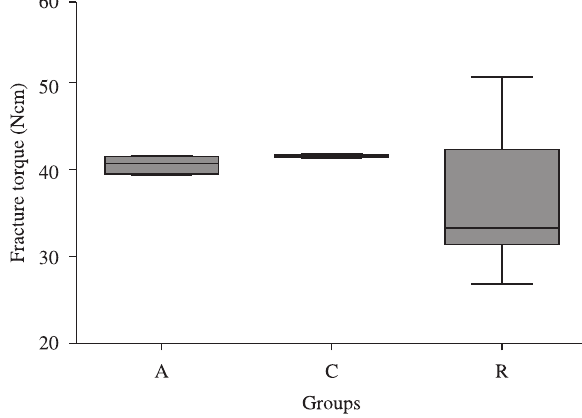
Figure 4. Box-plot of fracture torque values for all groups